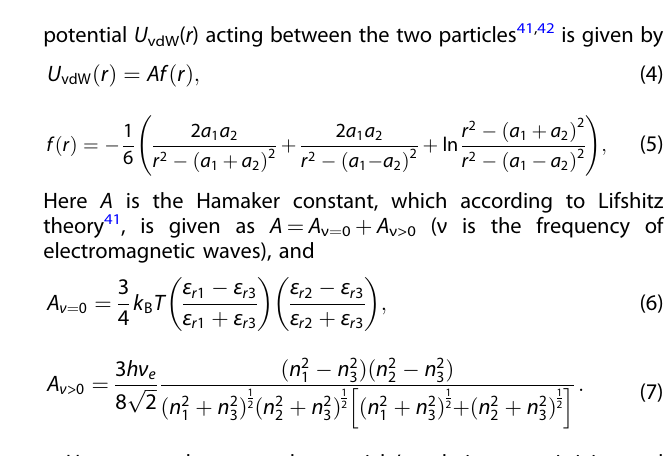
Fig. 5 SANS-USANS scattering pro fi les (left), and Guinier plot (right) for PS clusters in the space sample for four [NaCl] values. The curves are vertically shifted and superimposed for clarity. In the Guinier region, scattering intensity I ( q ) is proportional to exp(- R g2 q 2 ),where R g is the radius of gyration of the clusters, and q is the scattering vector. R g is obtained as the slope of the plot of log I ( q ) versus q 2